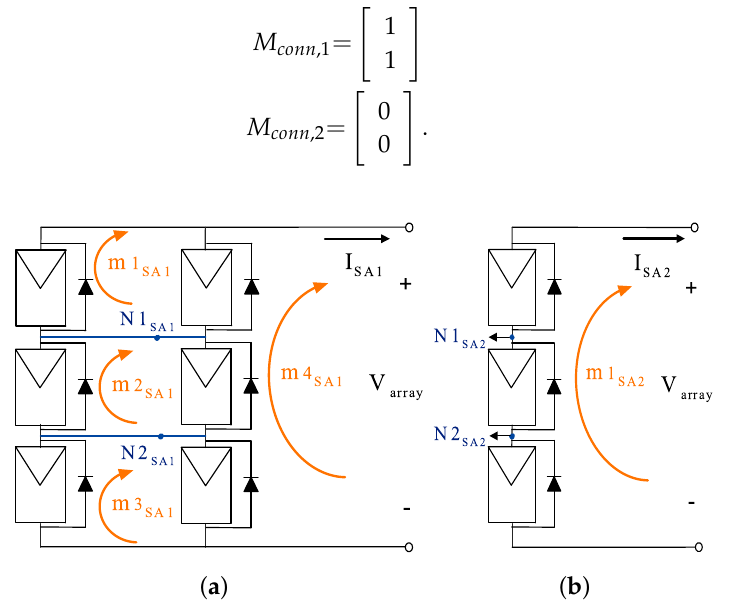
Figure 4. Sub-arrays of the PV array shown in Figure 3b ( a ) SA 1 and ( b ) SA 2